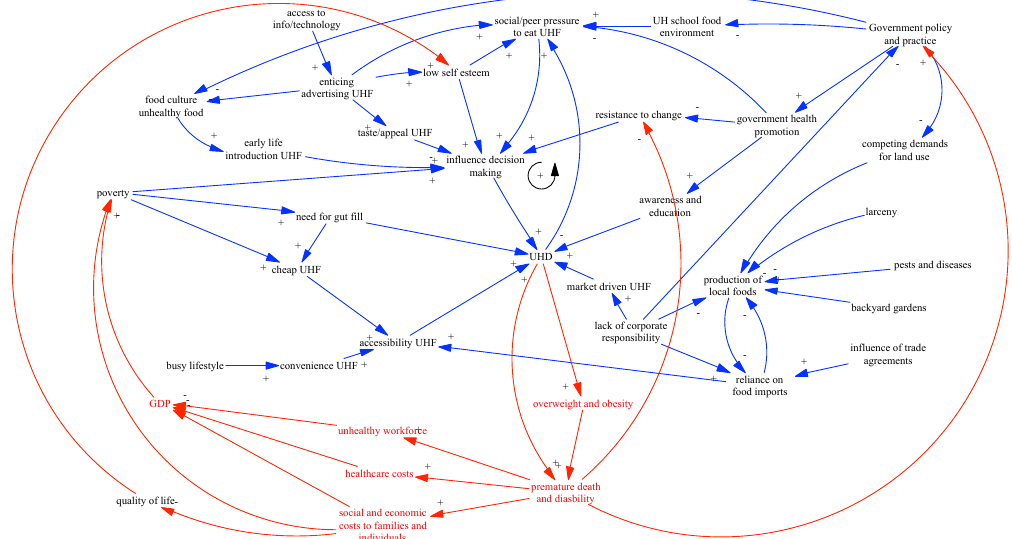
Figure A5. St. Vincent and the Grenadines preliminary causal loop diagram for unhealthy eating (red lines indicate where variables are acting to exacerbate unhealthy eating)